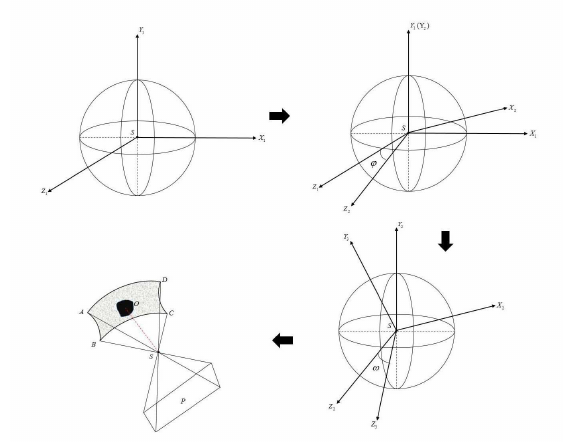
Figure 3. An illustration of two rotation processes to get a per- spective projected image from a cylindrical-projection panorama. Along the arrow: original sphere coordinate system S − X 1 Y 1 Z 1 , rotating ϕ about the Y 1 axis to get S − X 2 Y 2 Z 2 , rotating ω about the X 2 axis to get S − X 3 Y 3 Z 3 , and final projection